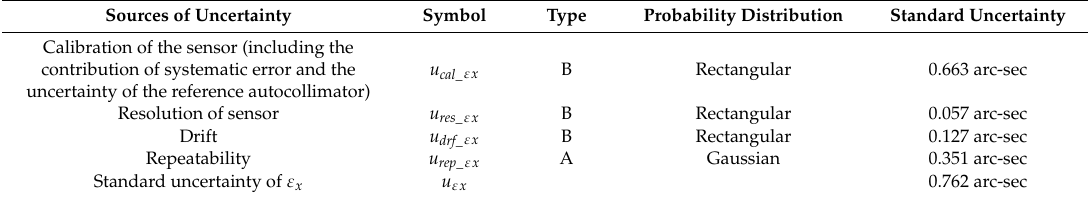
Table 1. Uncertainty of the inclination angle around the X-axis of the proposed precision level. Sources of Uncertainty Symbol Type Probability Distribution Standard Uncertainty